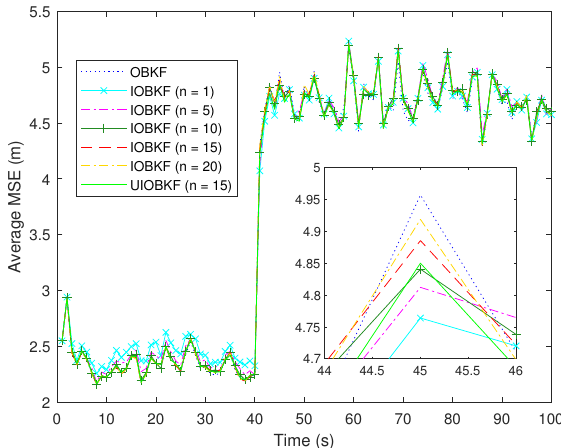
Figure 8. Average MSEs of different algorithms.